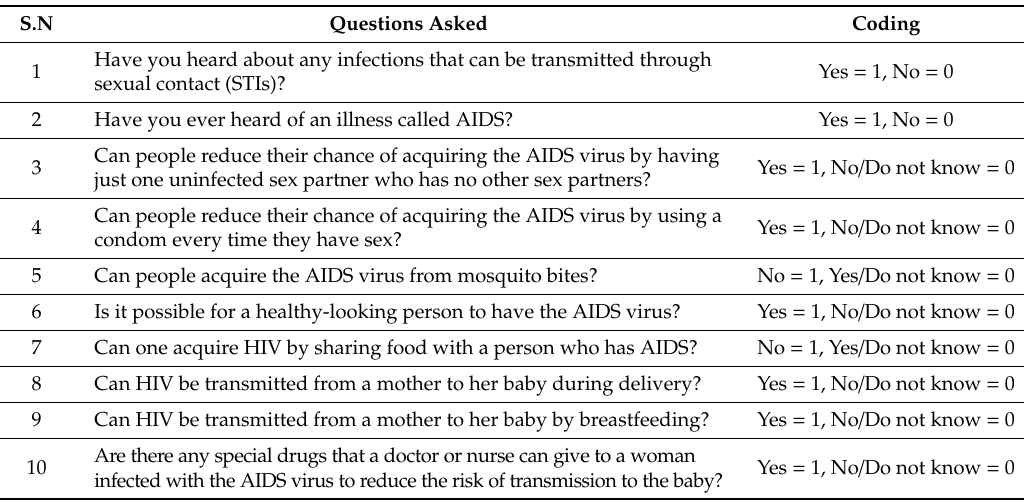
Table 1. Measurement of Human immunodeficiency virus (HIV) knowledge based on ten questions.